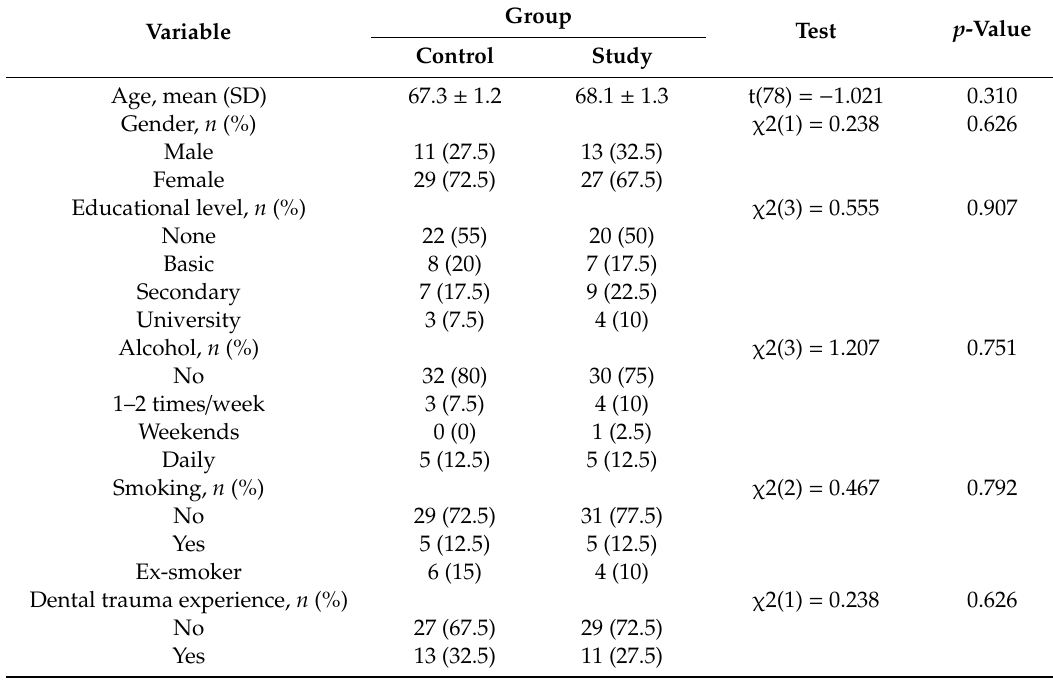
Table 1. Comparison of demographic characteristics and habits of the intervention and control groups.